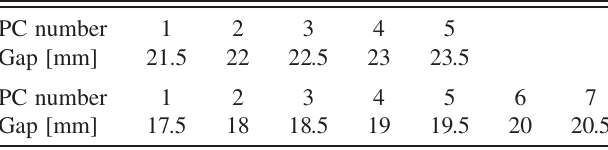
FIG. 30. (a) 5 PCs are set all at the gap calculated by the equivalent circuit simulation (Fig. 27). (b) 7 PCs are set all at the gap the equivalent circuit simulation (Fig. 27).